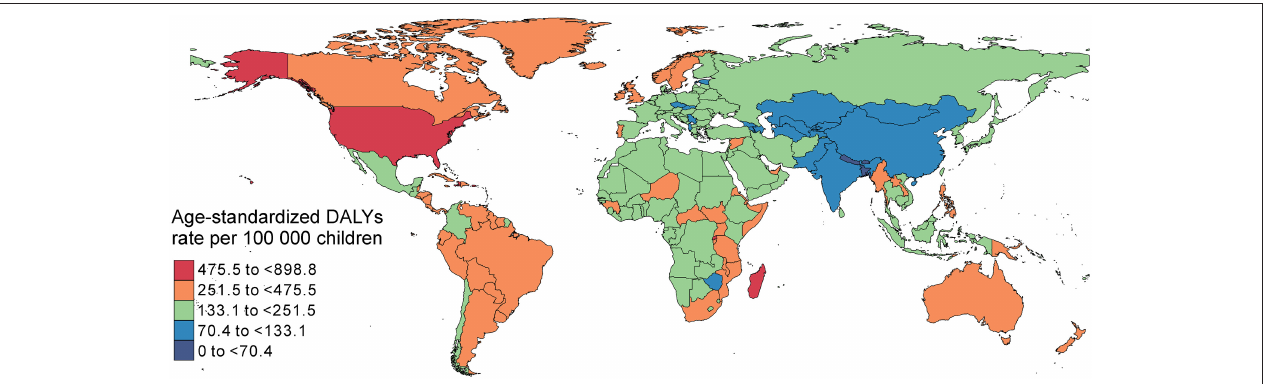
FIGURE 1 | Age-standardized DALYs due to childhood asthma per 100 000 children by country, both sexes, 2019. DALYs, disability adjusted life years.